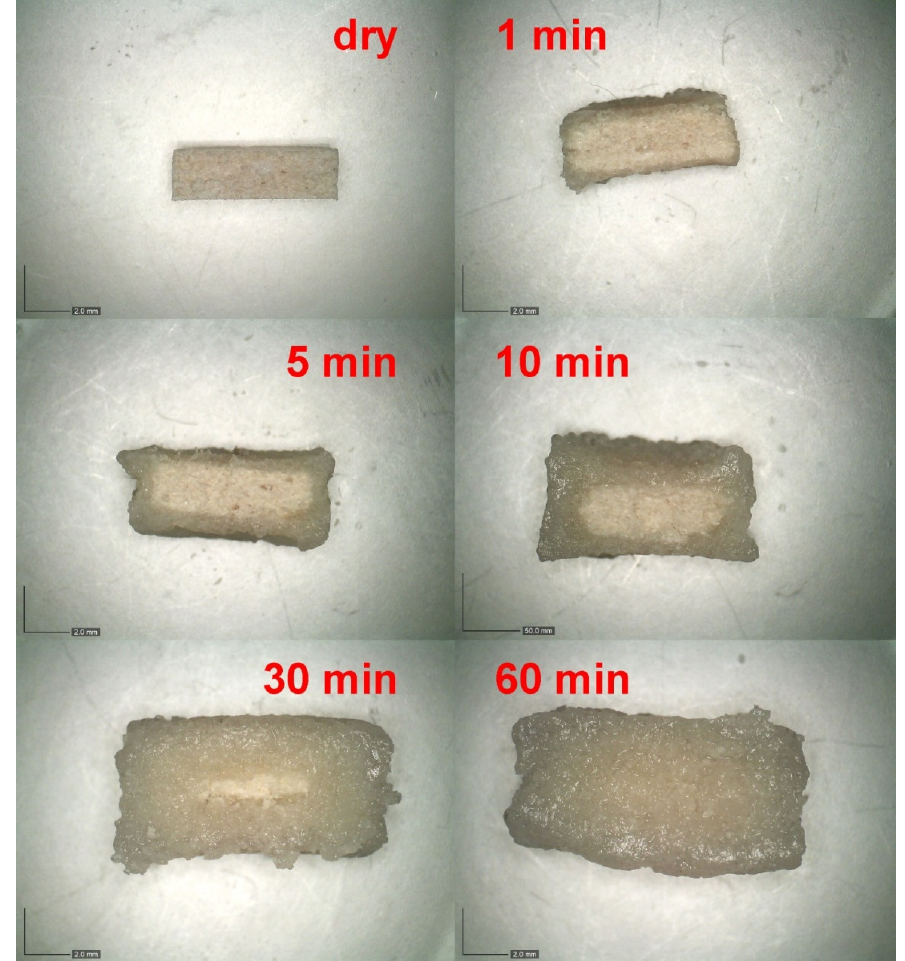
Figure 2. Example of the cross-section micrographs taken for the dissolution in acidic medium performed for the formulation F13 (CRG/CHTS = 3:1; Prosolv ® SMCC 90 used as the dry binder). In order to quantify the swelling kinetics, the following quantities were determined for each combination of tablet formulation and dissolution time: tablet height h (meas- ured in the cross-section view), vertical thickness of the dry tablet core h dry (measured in the cross-section view), and tablet diameter d (measured in the top view). Evolution of these quantities with dissolution time is shown for the particular formulations depicted in Figure 3A–C. Rapidity of the overall swelling (expressed by h and d ) seemed to be universally driven by the CRG/CHTS ratio; the more CRG, the faster the swelling. This may be explained by the presence of the –OSO 3- groups of CRG [2], which facilitated easier absorption of the polar medium (compared to the –NH 2 groups of CHTS). The ra- pidity of the swelling was further supported by the presence of the CaSO 4 ·2H 2 O (ionic salt) used as a dry binder. Interestingly, the final h and d values representing the magni- tude of the swollen tablets seemed to show anisotropic behavior. The overall tablet height (thickness) was clearly driven by the type of dry binder used (see Figure 3A), where Prosolv ® SMCC 90 caused additional tablet expansion (compared to the alternative in- creased CRG and CHTS contents denoted as “no binder”—see Table 1), while CaSO 4 ·2H 2 O led to the lowest overall h due to the very limited additional liquid uptake by this salt, as well as by its generally low solubility. On the other hand, in the case of the tablet diameter, no such clear dependence could be recognized. The final value of the